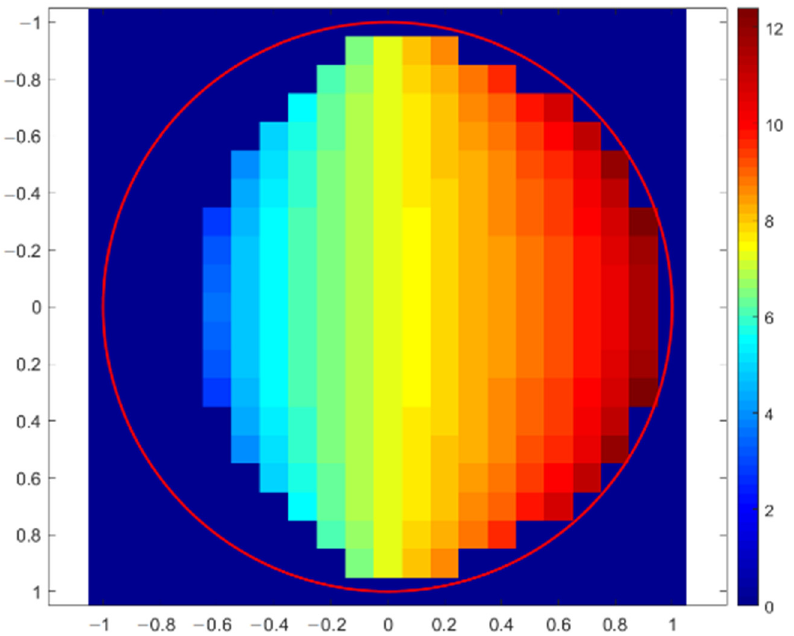
Figure 7. Copper concentration map of sterling silver sphere determined with Monte Carlo simulation of XRF scanning (in XY-axes) applying Cu-K α and Ag-K α lines. The correct Cu concentration was 7.5%.